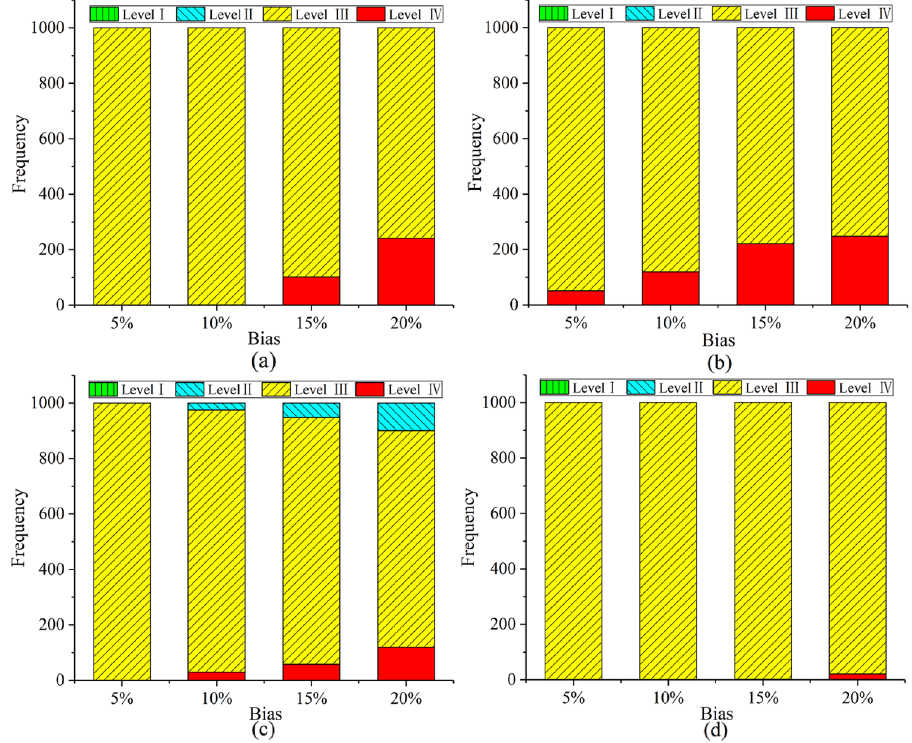
Figure 10. Four risk evaluation methods for tunnel collapse risk assessment after 1000 iterations under different deviation levels: ( a ) SVM; ( b ) BN; ( c ) CM; ( d ) Multi-source information fusion